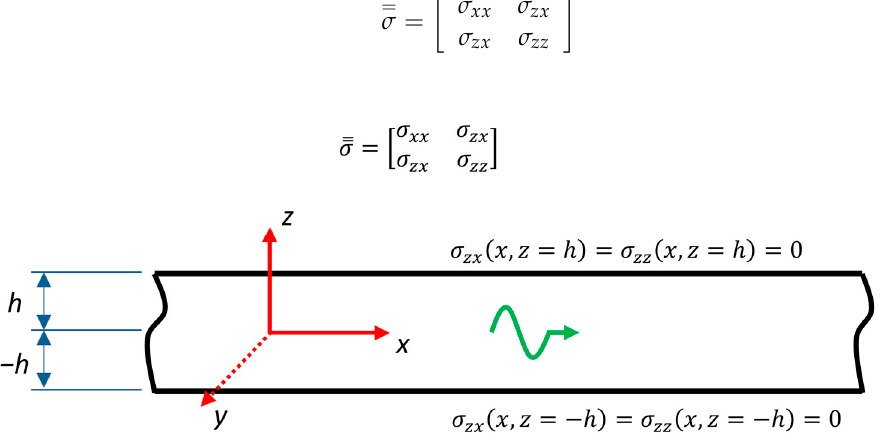
Figure 1. Geometry of the Lamb wave problem .